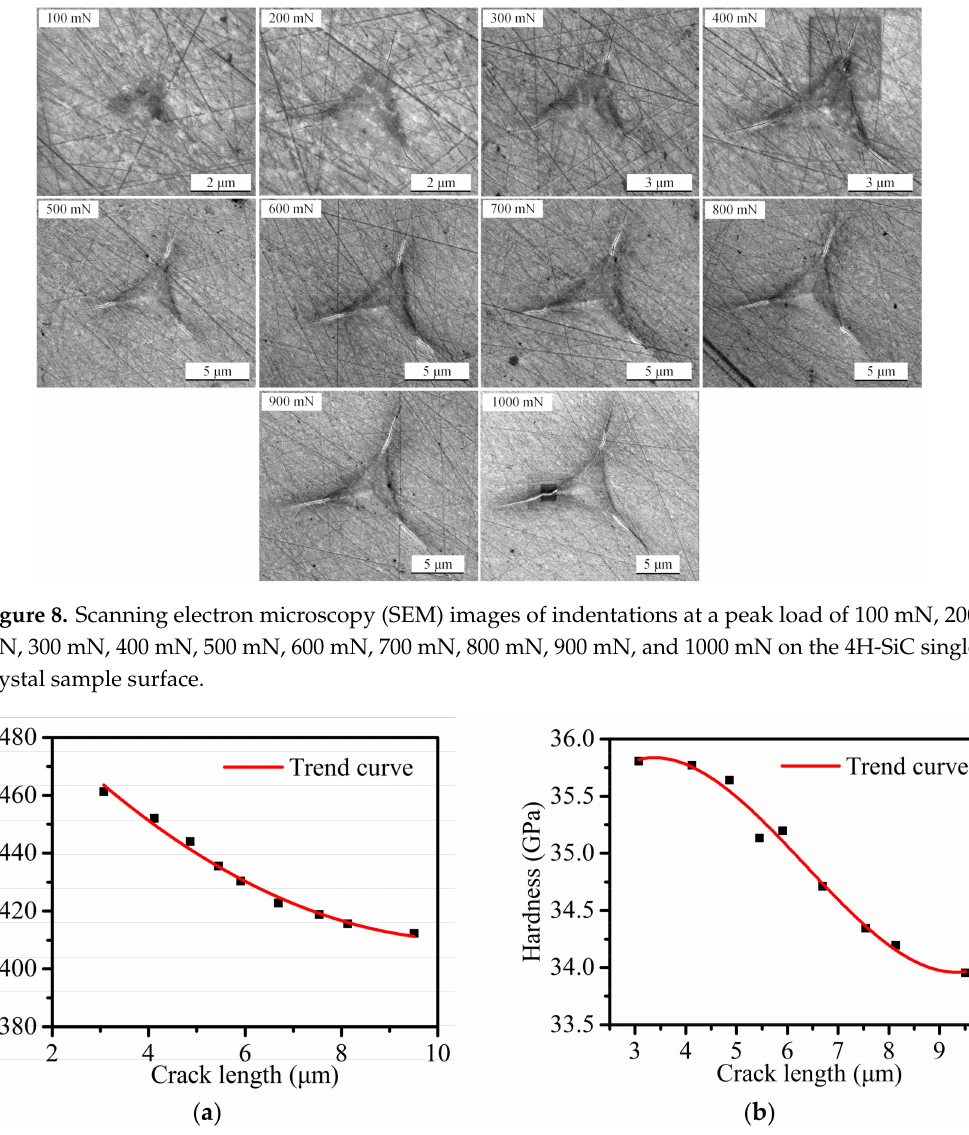
Figure 9. Mechanical properties as a function of crack length: ( a ) elastic modulus as a function of crack length and ( b ) hardness as a function of crack length. Table 2. The elastic modulus of 4H-SiC measured by di ff erent